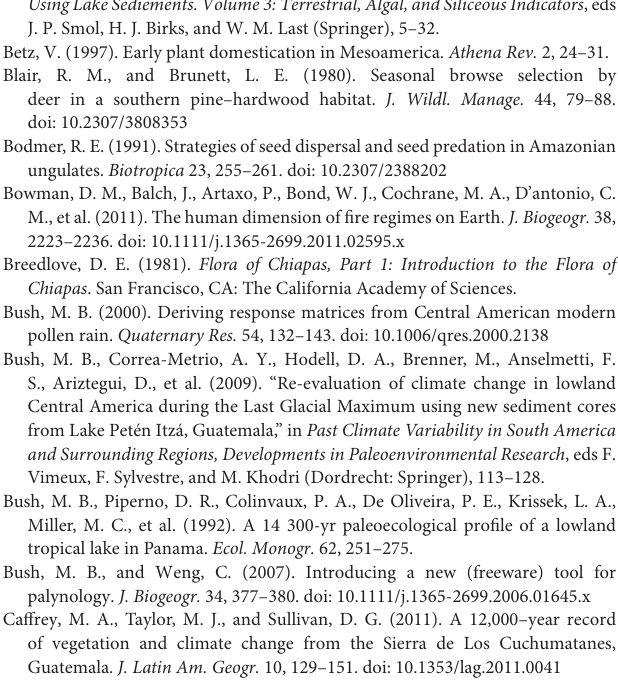
Data Sheet 1 | Raw Palaeoecological